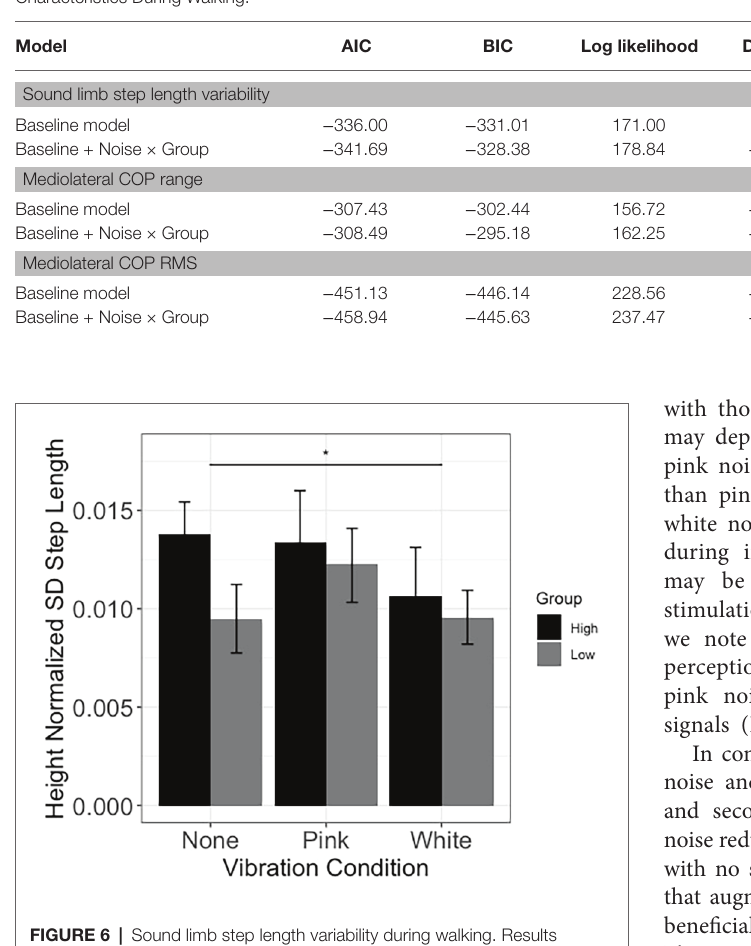
FIGURE 6 | Sound limb step length variability during walking. Results displayed as a function of vibration condition and light touch threshold group (higher and lower denote individuals with higher and lower thresholds of perception to light touch, measured at the tibial crest). Error bars reflect 95% confidence intervals. SD, standard deviation. The horizontal bar reflects the comparison between the none and white noise